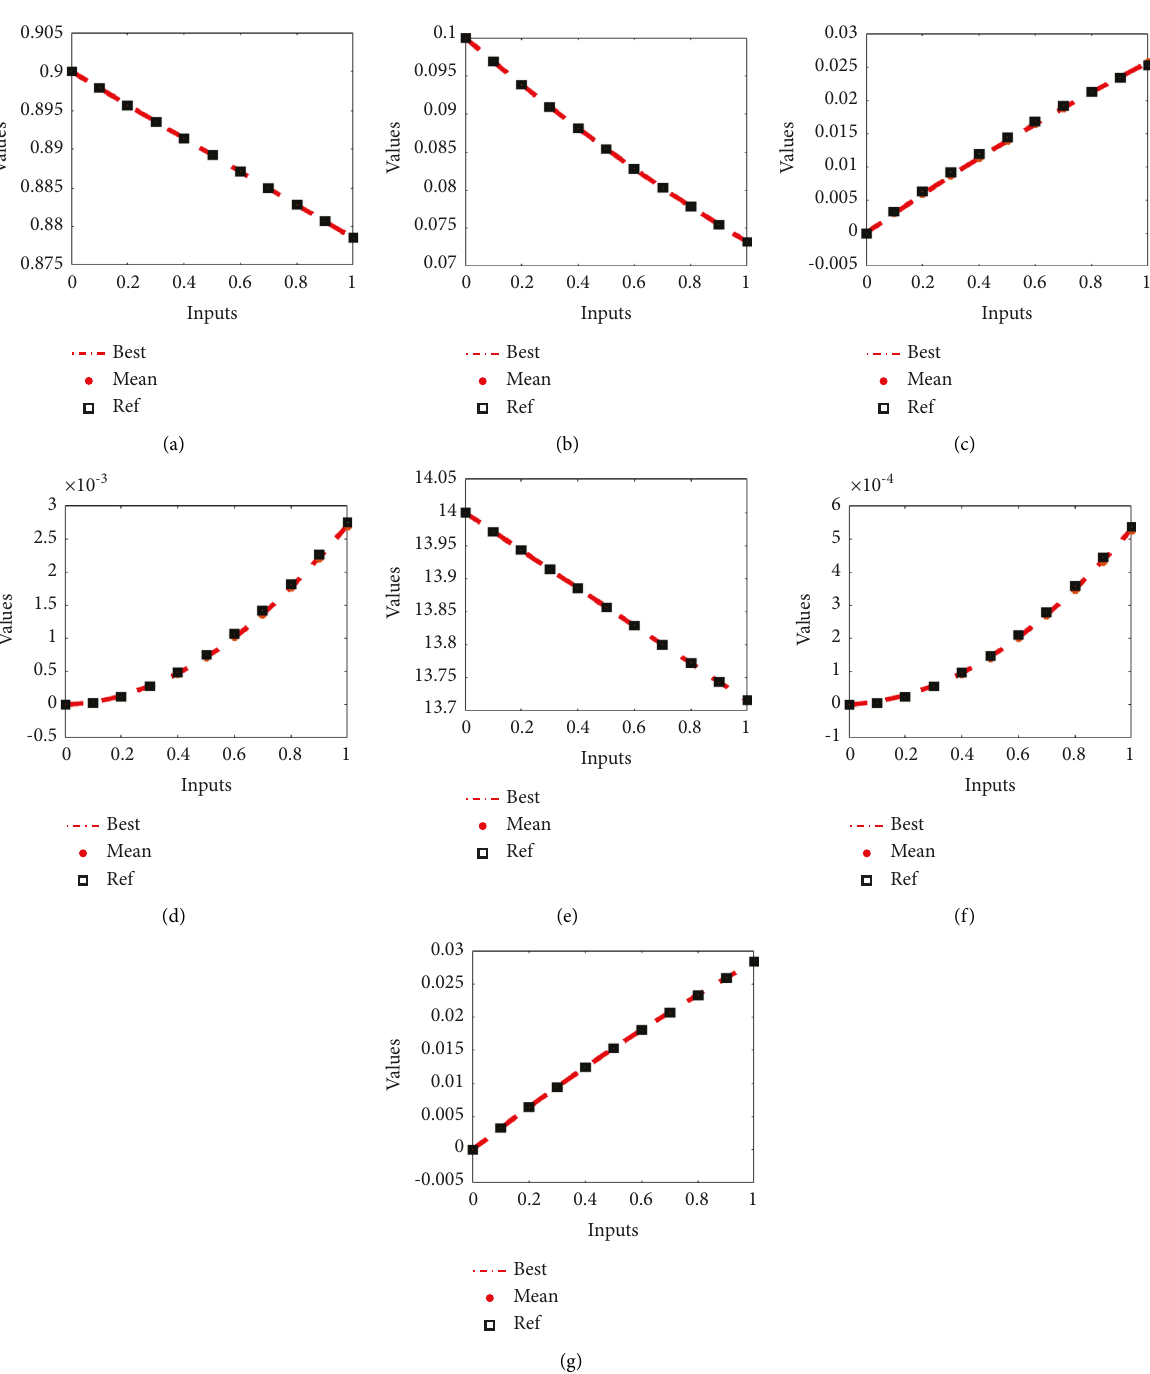
Figure 3: Comparison of the mean, exact, and best results for the mathematical SEIR-NDC system. (a) Result comparison of 􏽢 S ( y ) . (b) Result comparison of 􏽢 E ( y ) . (c) Result comparison of 􏽢 I ( y ) . (d) Result comparison of 􏽢 R ( y ) . (e) Result comparison of 􏽢 N ( y ) . (f) Result comparison of 􏽢 D ( y ) . (g) Result comparison of 􏽢 C ( y )